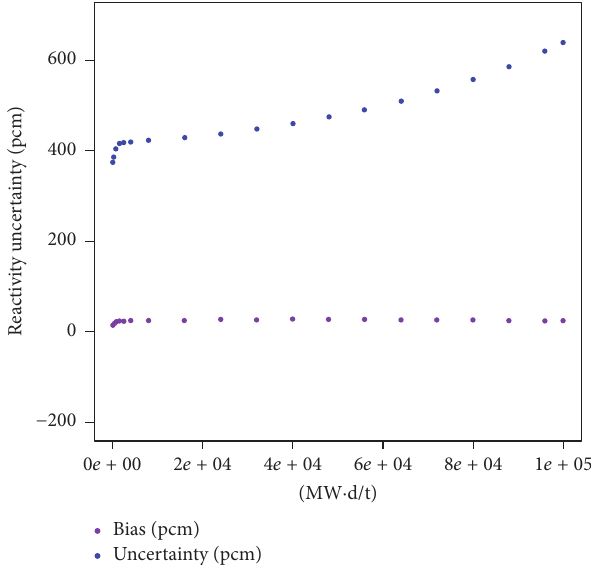
Figure 7: Uncertainty on the reactivity during depletion (pcm at 1𝜎 ).